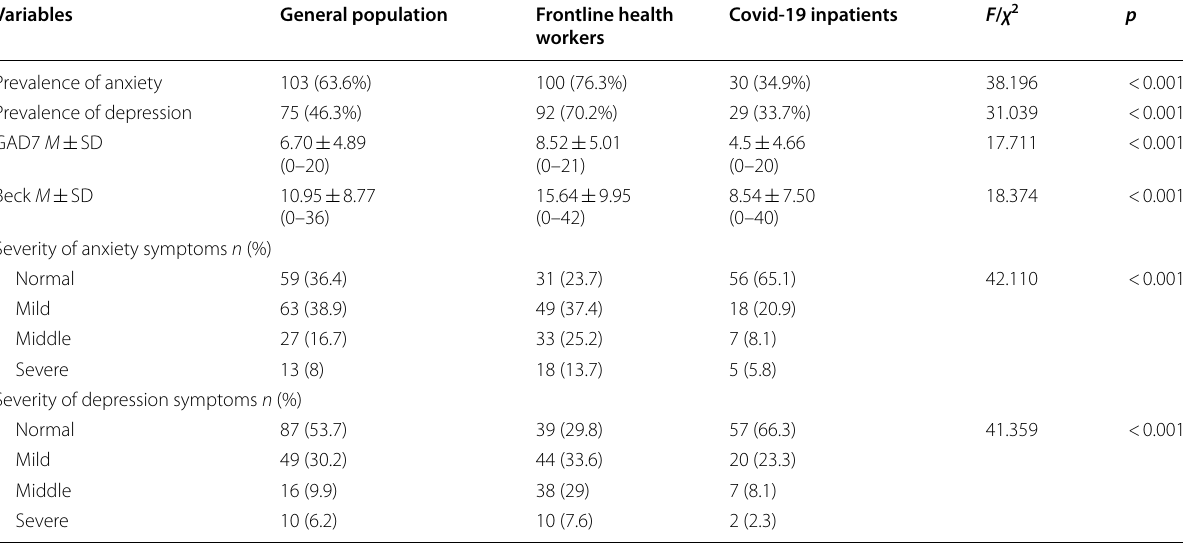
Table 2 The GAD‑7 and BDI findings of participants